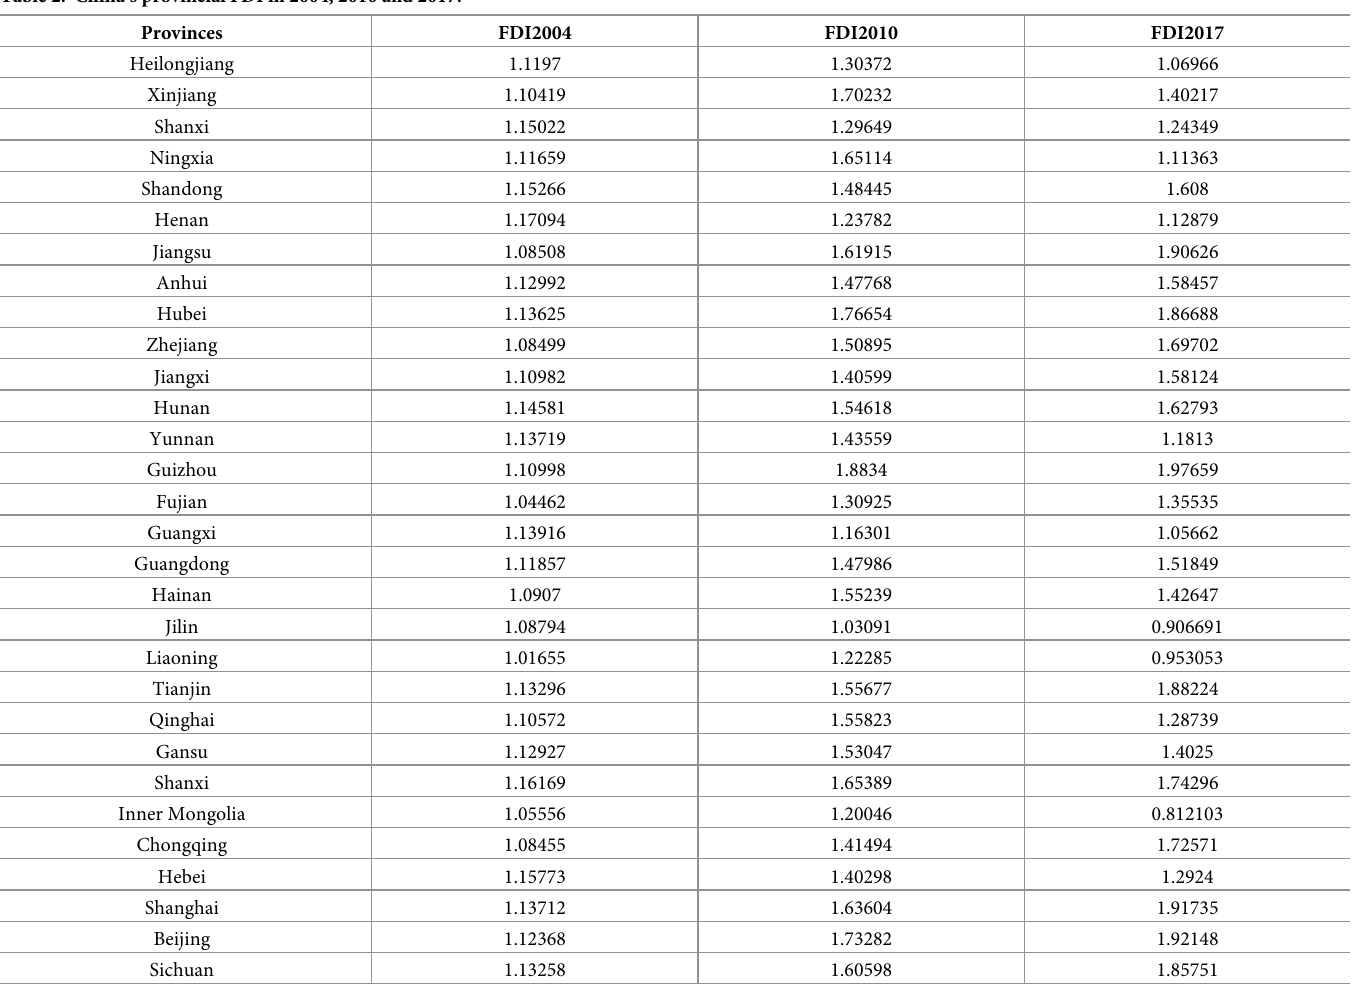
Table 2. China’s provincial FDI in 2004, 2010 and